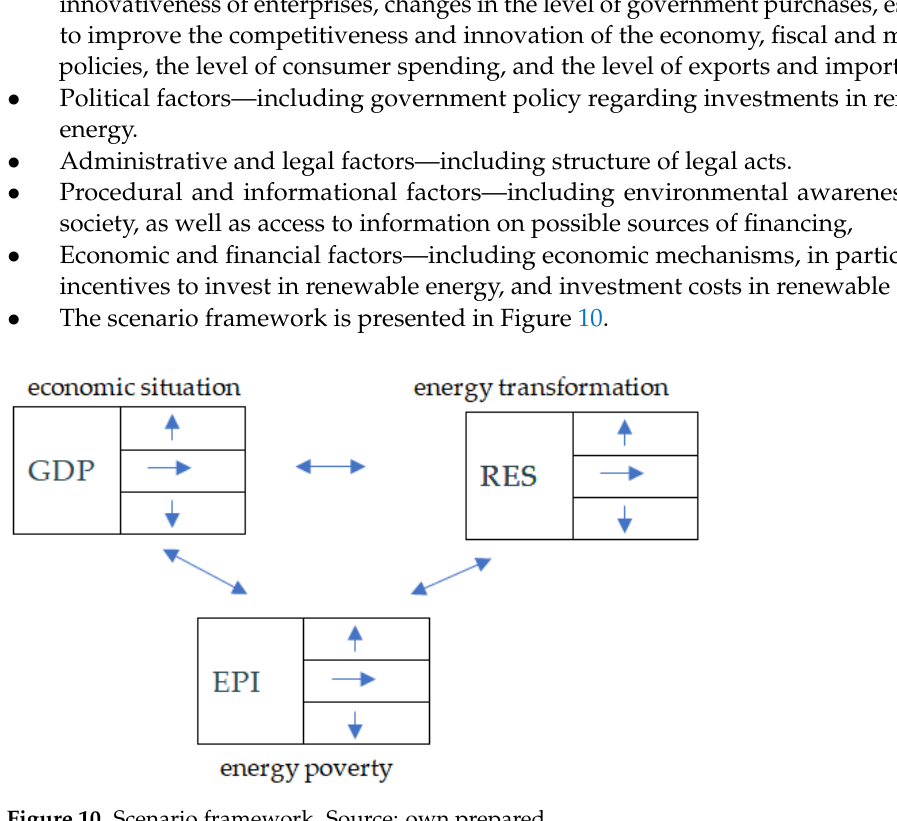
Table 2. Renewable energy development scenarios. Optimistic scenario